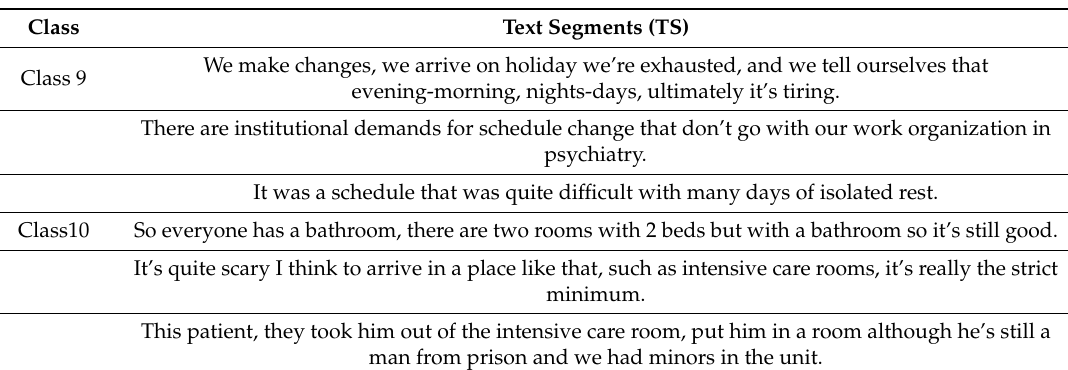
Table 3. Hierarchical structure and words associated with